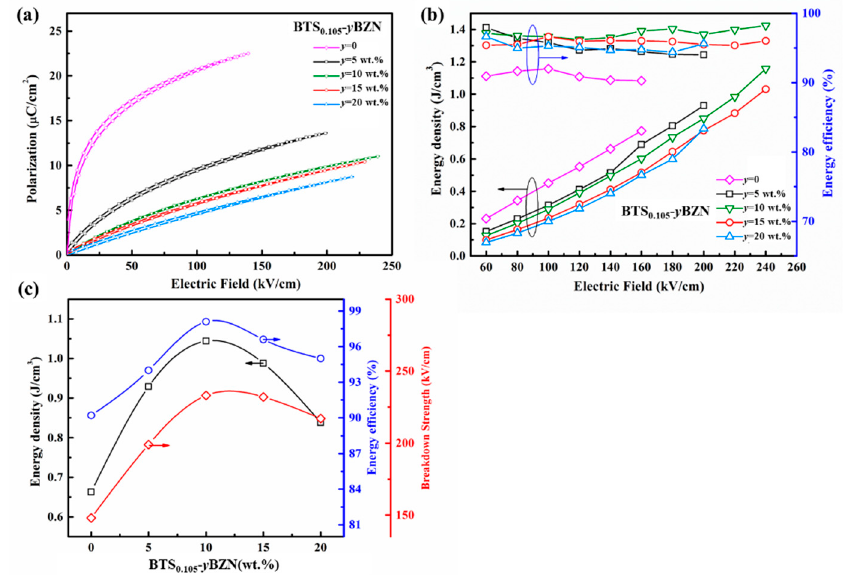
Figure 6. The energy storage properties for BTS 0.105 − y BZN ( y = 5 wt %, 10 wt %, 15 wt %, 20 wt %)